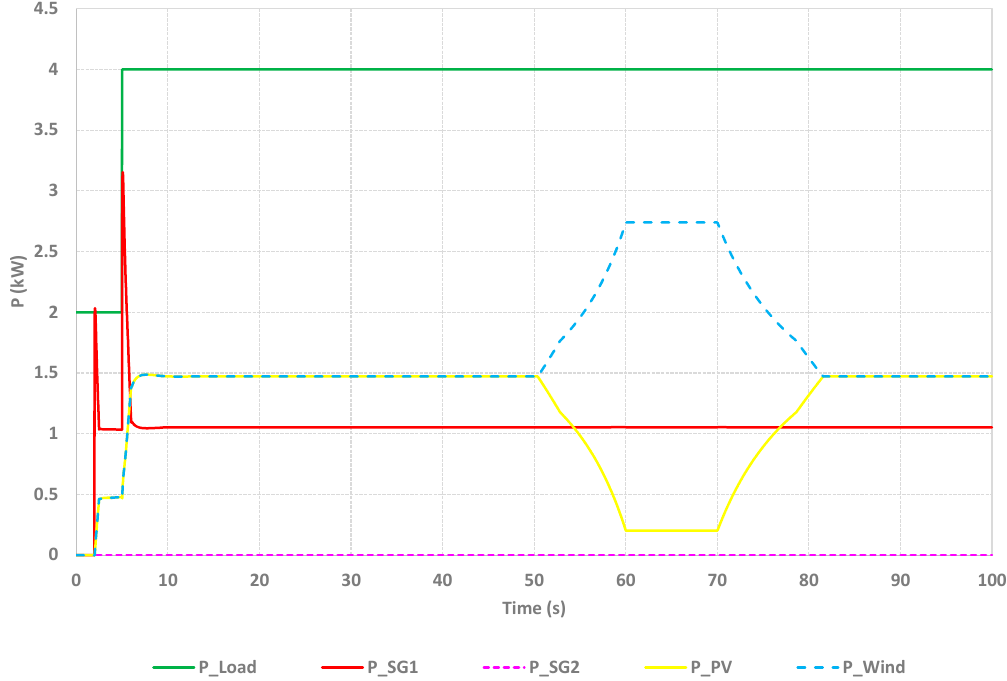
Figure 7. Scenario 3a: Cloud transient analysis for maximum solar PV and wind generation for a 4 kW demand.